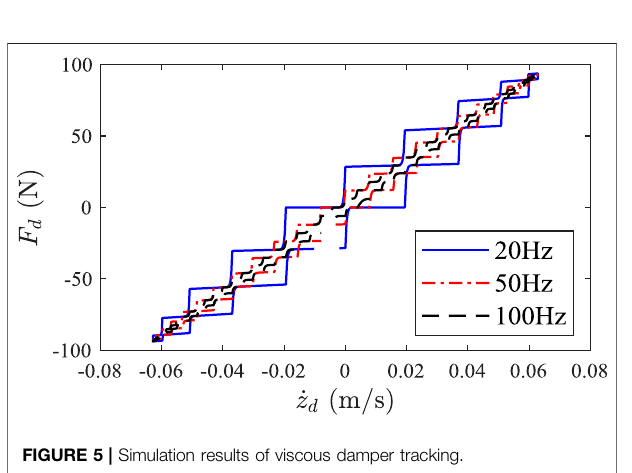
FIGURE6| The schematicdiagram oftheseat system: (A) thestructure ofthescissors-linkageseat; (B) theschematicdiagramoftheskyhook control for the seat